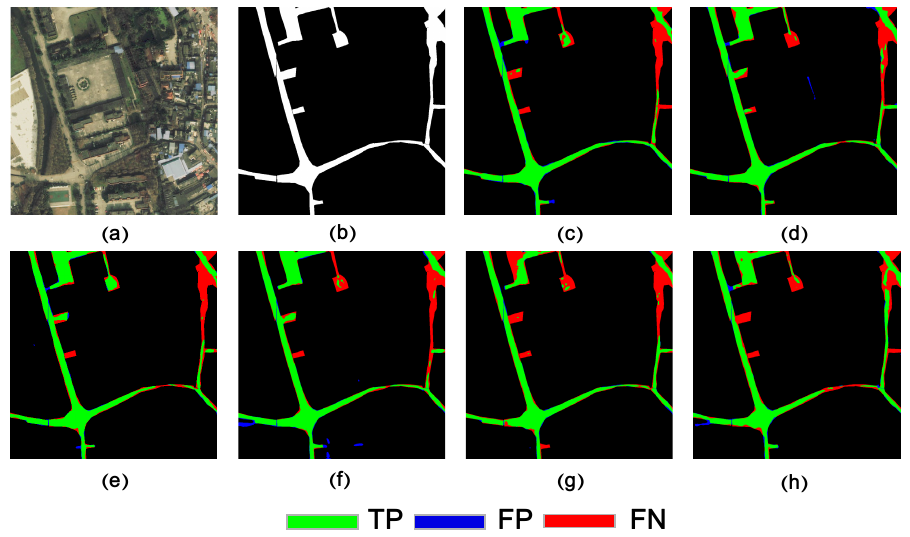
Figure 12. Results of ablation experiments on the Chongzhou dataset. ( a ) RGB satellite imagery. ( b ) Ground truth. ( c ) HRNet. ( d ) HRNet with multispectral input. ( e ) MSFANet without multispectral input and CFFM. ( f ) MSFANet without multispectral input. ( g ) MSFANet without MFAD module. ( h ) MSFANet.